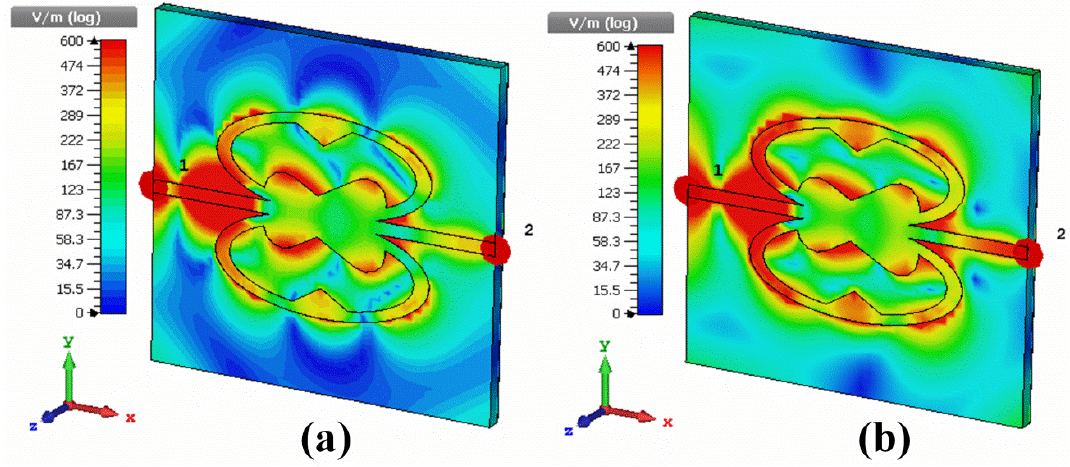
Figure 12. ( a ) Simulated electric field distributions for branded diesel at 8.39 GHz and ( b ) unbranded diesel at 8.41 GHz.